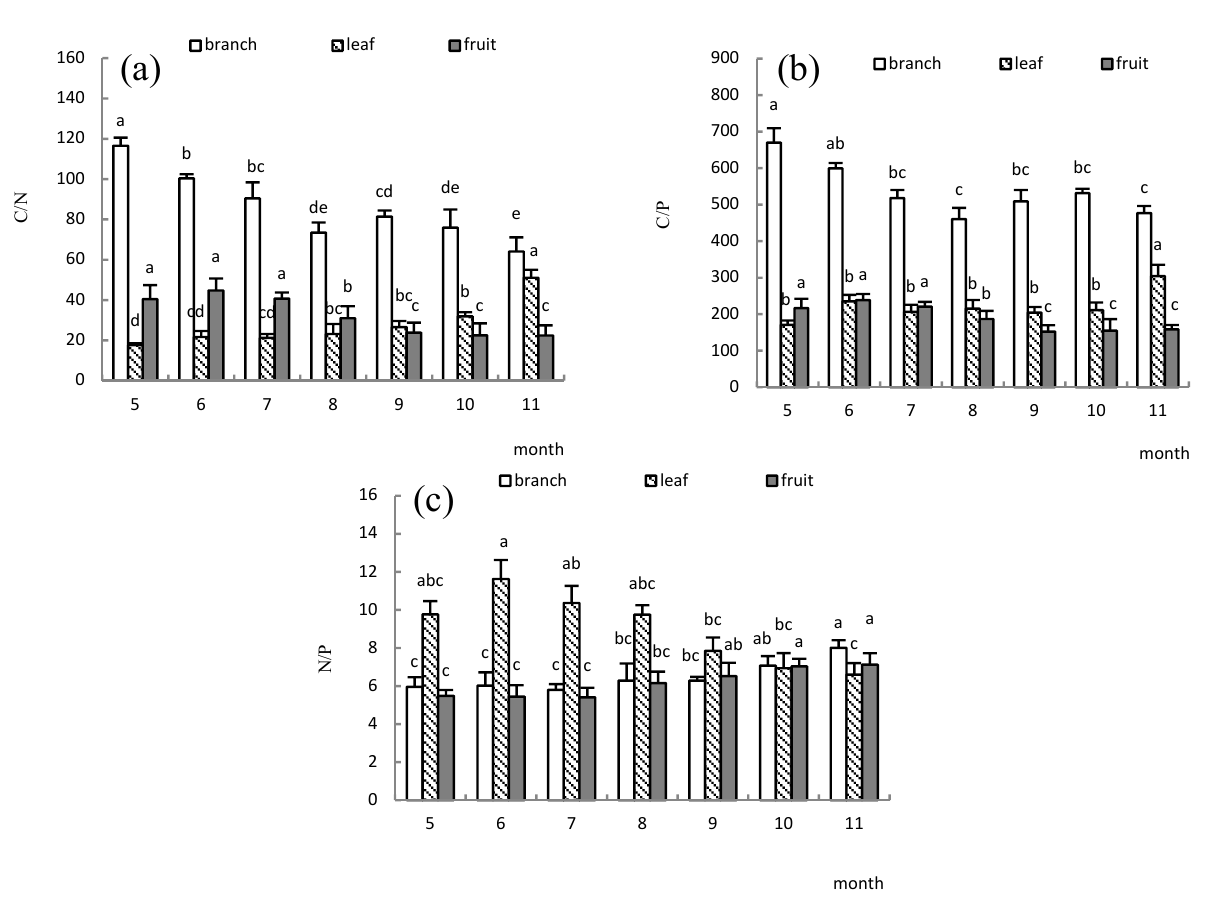
6 of 15 Figure 2. Monthly dynamic of C ( a ), N ( b ), P ( c ) contents in different organs of male plants of F. velutina . Note: Means of different months not sharing the same letter indicated significant differ- ences at an alpha level of 0.05, according to an LSD test. The leaf C and branch C contents of male plants were relatively similar in each month of the growing season. The leaf N and leaf P contents of male plants of F. velutina were both higher than those of the branch in each month of the growing season. In May, the N and P contents of leaves were 6.64 times and 3.73 times higher than those in branches, respectively, but in November, the difference of the N and P contents between them be- came relatively small. 3.3. Dynamics of C/N/P Ratios in Different Organs of Female Plants of F. velutina The leaf C/N ratios of female plants varied from 17.51 to 51.02, those of branch varied from 64.03 to 116.55, and those of fruits varied from 22.39 to 44.73 during the growing season (Figure 3a). The leaf C/P ratios varied from 171.04 to 304.45, those of branch varied from 477.18 to 670.32, and those of fruit ranged from 152.58 to 234.48 (Figure 3b). The